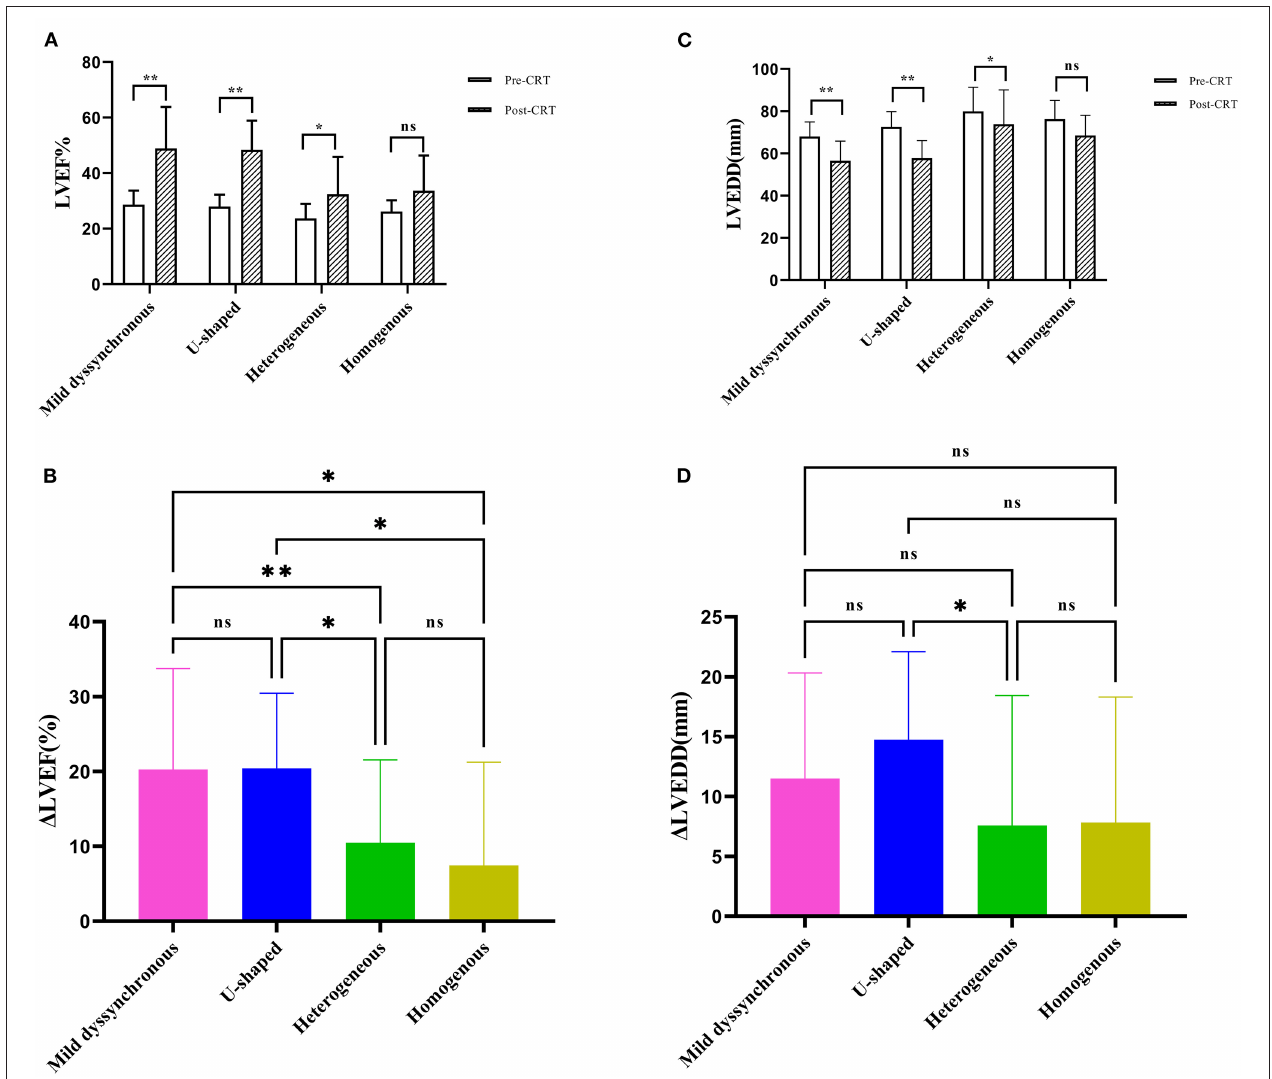
FIGURE 3 | Comparison of echocardiographic measurements. (A) The panel shows the comparison of LVEF between baseline (pre-CRT) and post-CRT. (B) The panel shows the comparison of 1 LVEF among the four groups. (C) The panel shows the comparison of LVEDD between pre-CRT and post-CRT. (D) The panel shows the comparison of 1 LVEDD among the four groups. * P < 0.05; ** P < 0.01; ns, no statistically significant. 1 LVEF, the changes of left ventricular ejection fraction; 1 LVEDD, the changes of left ventricular end-diastolic